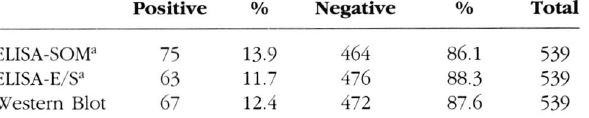
Table 1. Percentage of samples positive by ELISA and Western Blot.